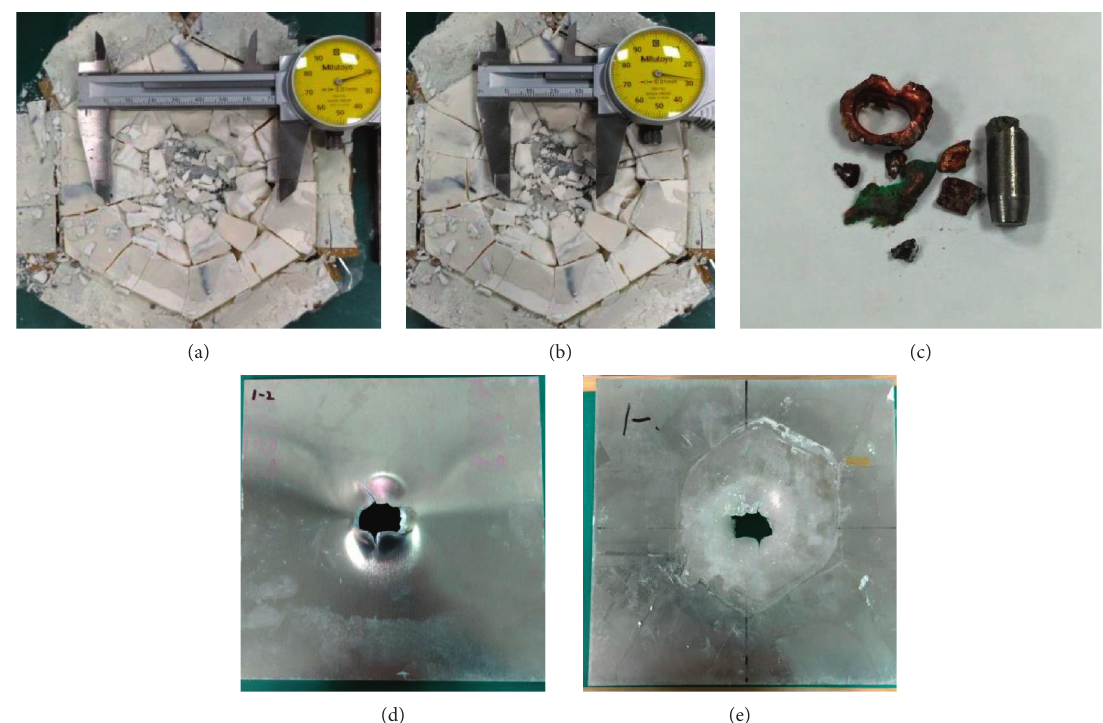
Figure 10: 5% 333 FGM + 4 mm Al backplate. (a) The bottom of the ceramic conoid. (b) The top of the ceramic conoid. (c) Residual bullet. (d) The back of the aluminum backplate. (e) The front of the aluminum plate.